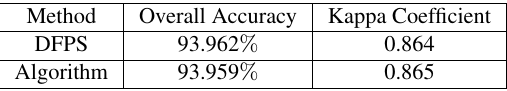
Table 4: Accuracy assessment of the